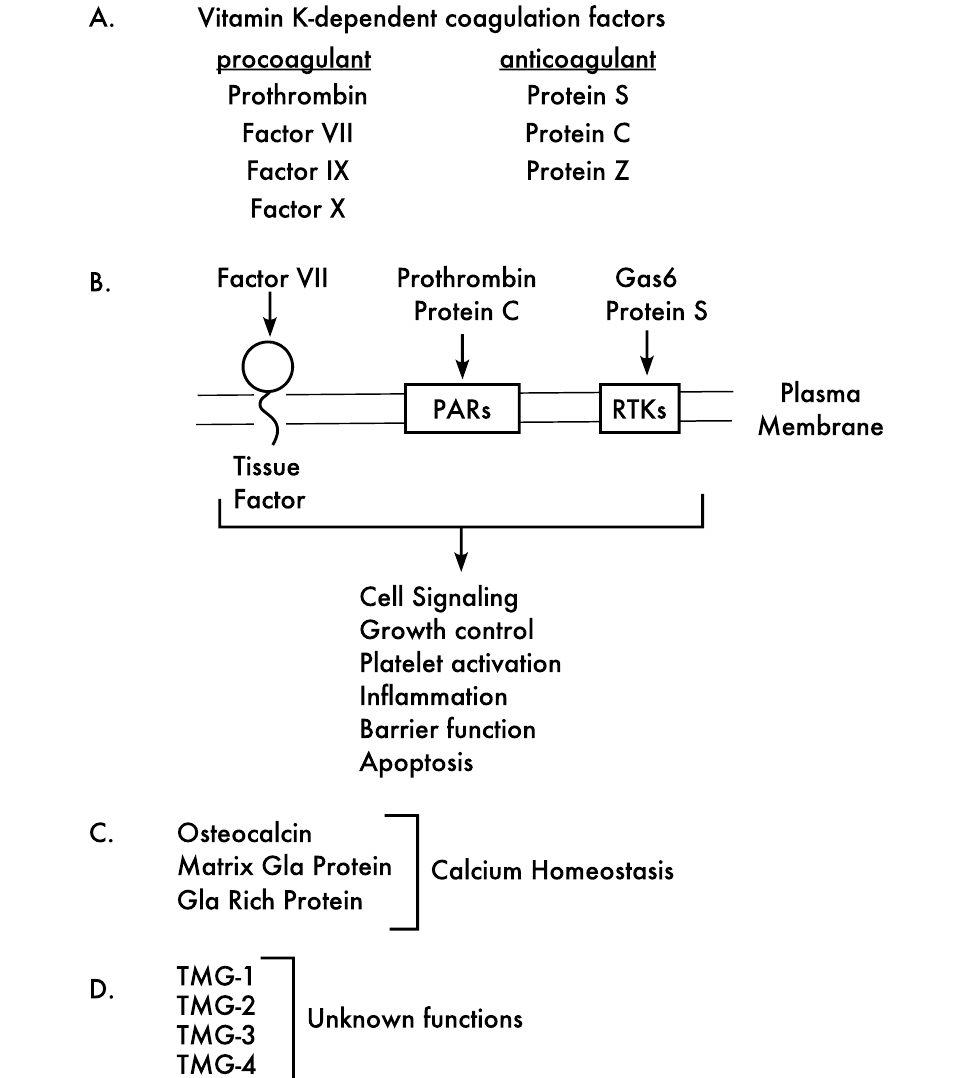
Figure 1. Vitamin K-dependent proteins impact multiple physiologies. ( A ). Many of the vitamin K-dependent proteins are essential for blood clotting, either supporting (procoagulant) or attenuating (anticoagulant) hemostasis. ( B ). Msost of the coagulation factors, as well as Gas6, signal through various receptors on the cell surface. Some examples of receptors are tissue factor, platelet activated receptors (PARS) and receptor tyrosine kinases (RTKs), which mediate multiple physiologies. The scheme shows zymogen nomenclatures for simplicity; however, the function of VKD coagulation factors requires activation (e.g., of prothrombin to thrombin). ( C , D ). VKD proteins that have roles beyond hemostasis have also been identified. Some regulate calcification ( C ), while others have functions that remain to be determined ( D ). TMG stands for Transmembrane Gla Protein, a family of proline-rich proteins that are also referred to as PRGP.